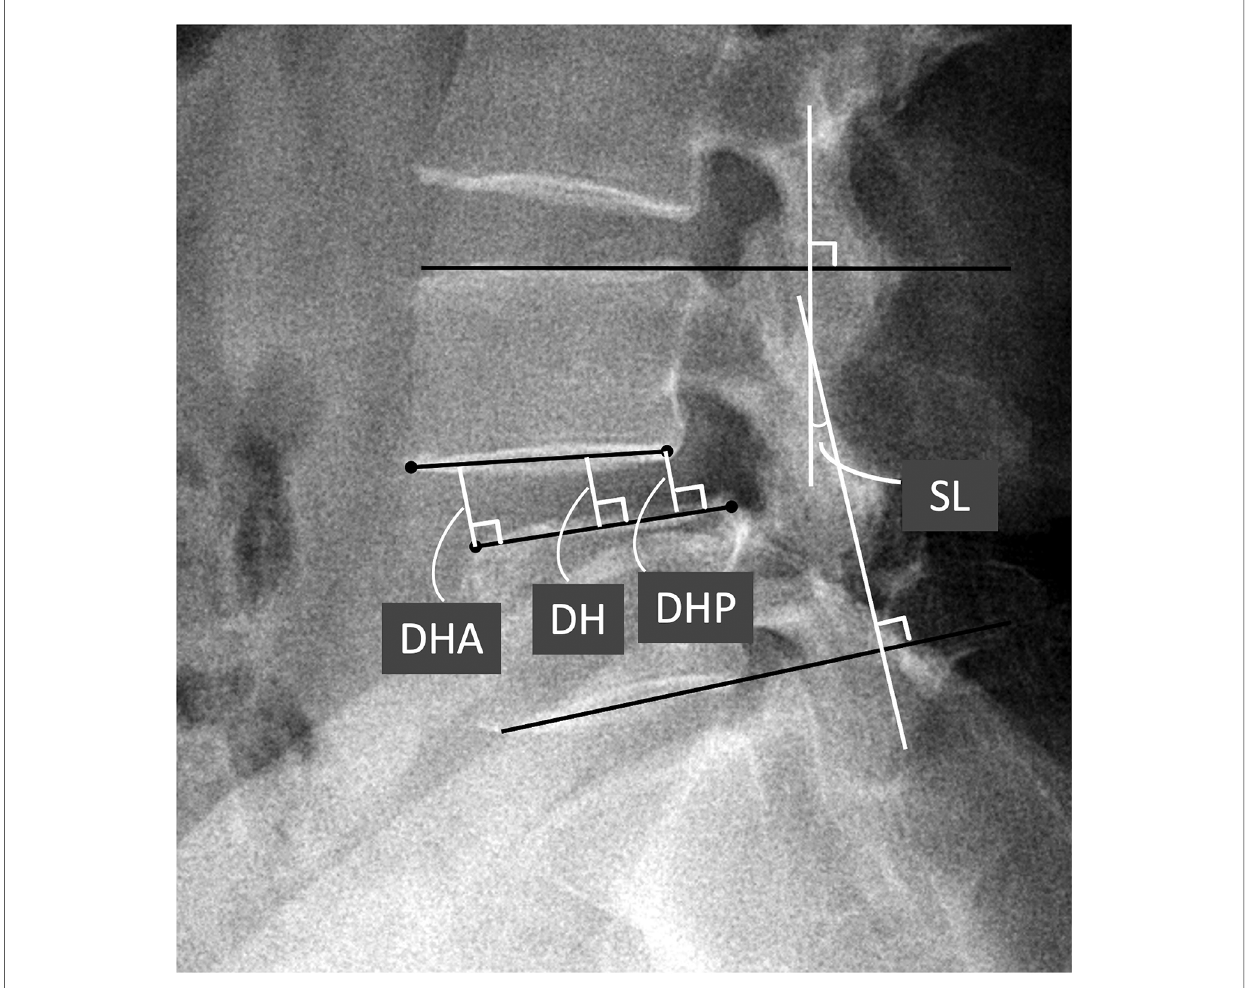
FIGURE 1 De fi nitions of radiographic parameters. SL, DH, DHA, and DHP on the standing lateral view of lumbar spine. SL, segmental lordosis; DH. disc height; DHA, anterior DH; DHP, posterior